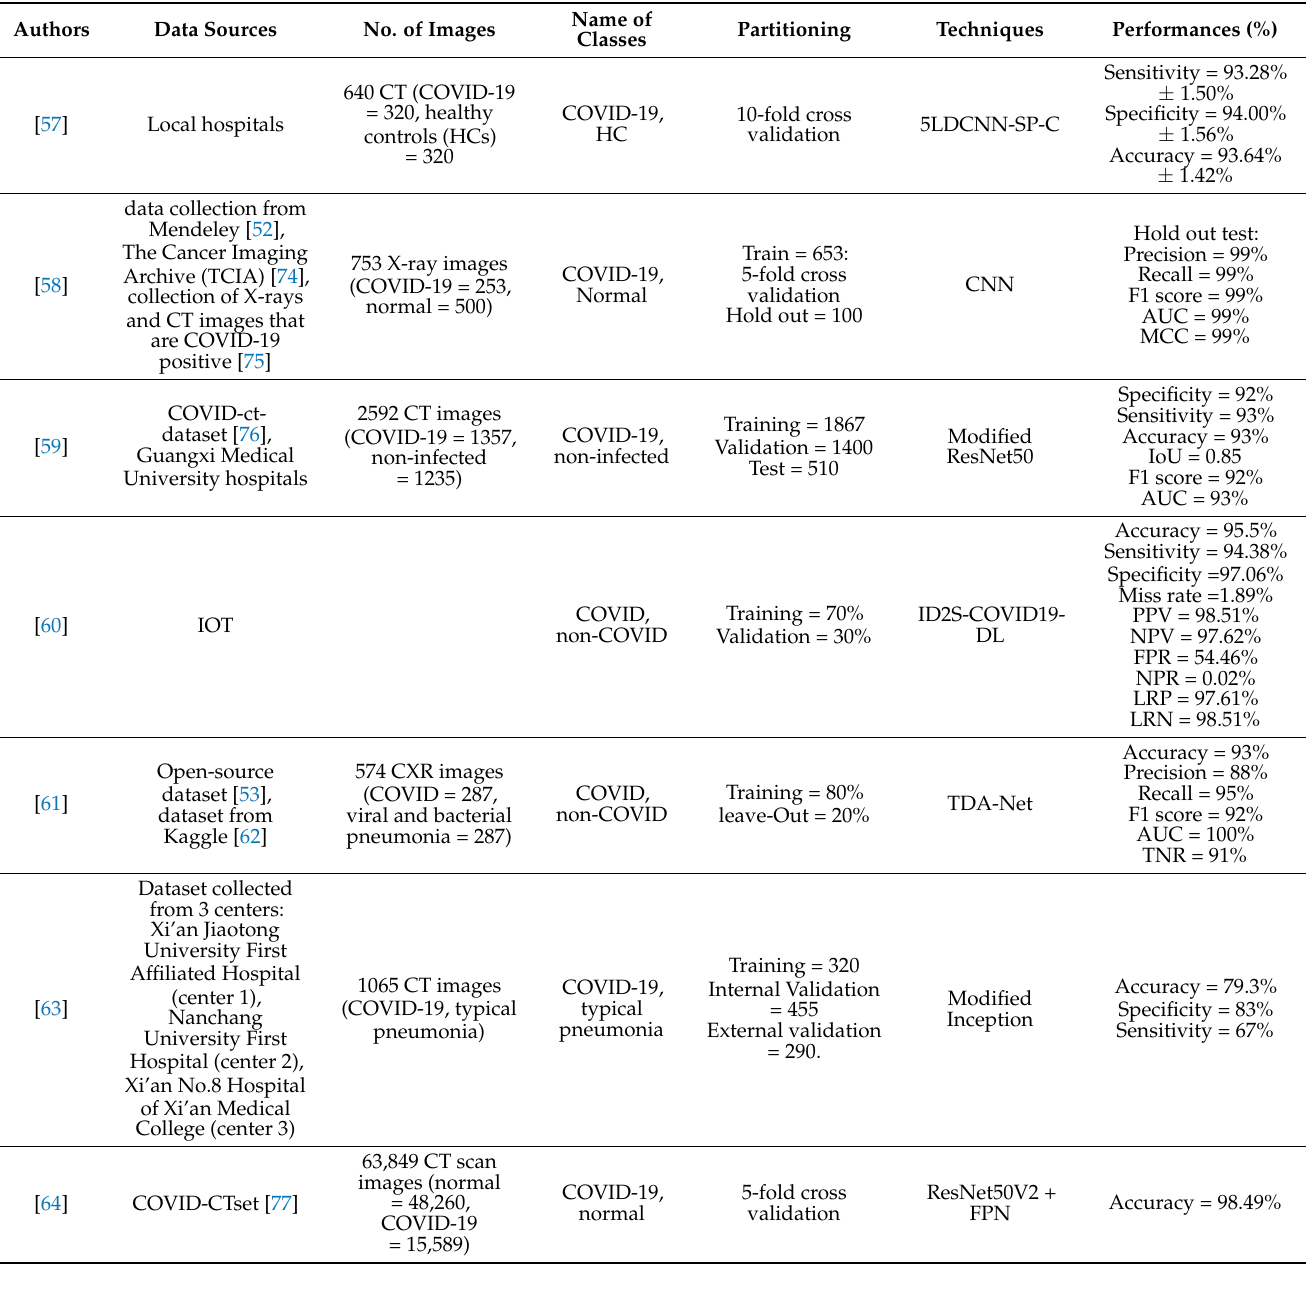
Table 6. Summary of deep learning based COVID-19 binary classification using custom